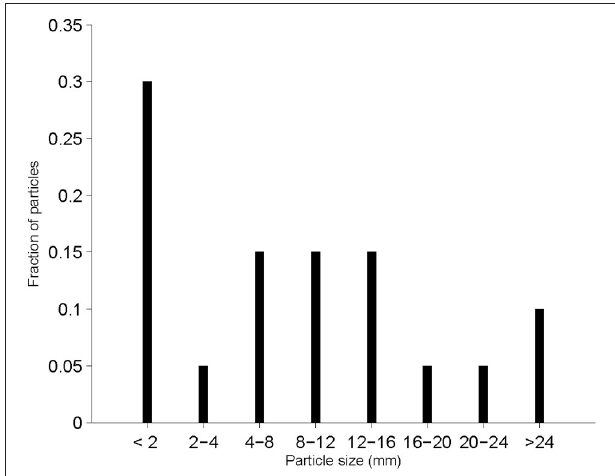
FIGURE 4 | Size distribution of fecal particles used in the DREAM simulations Buryniuk and others.